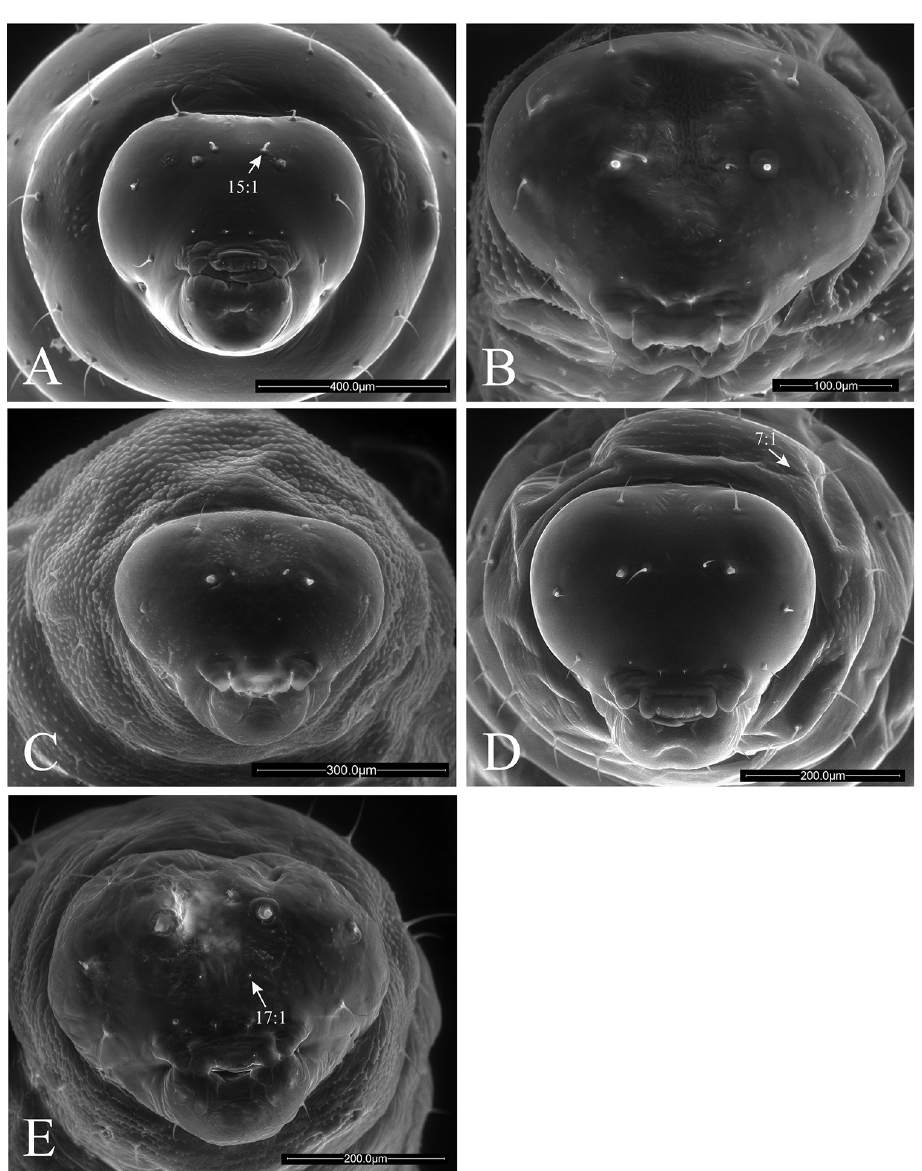
Figure 8. Anterior views of head of Ormyrus terminal-instar larvae. A Ormyrus papaveris B O. pomaceus ex Trigonaspis mendesi (Cynipidae) C O. pomaceus ex Plagiotrochus razeti (Cynipidae) D O. rufimanus E O. wachtli . Character states for outstanding features are pointed.